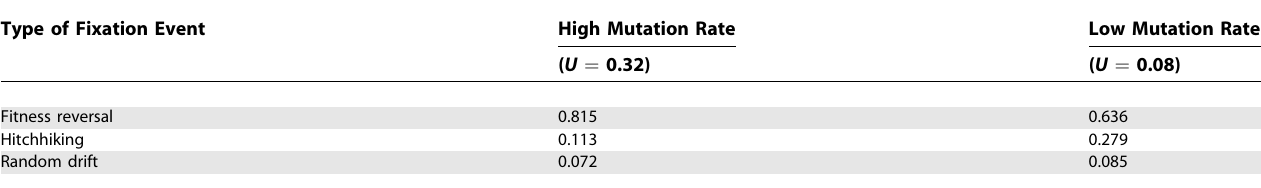
Table 1. Forces Leading to the Fixation of Deleterious